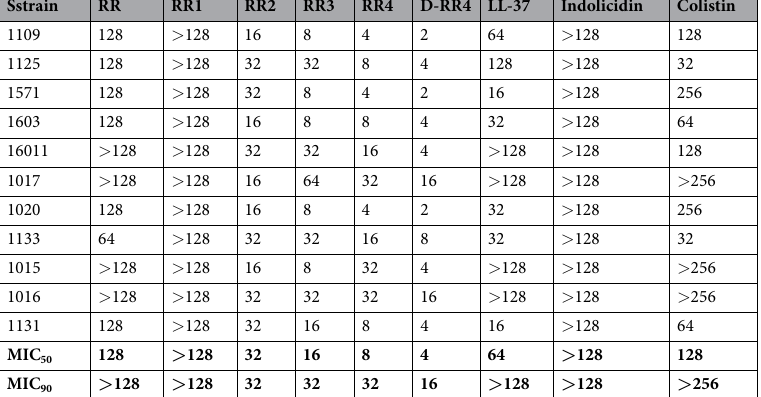
(Supplementary Fig. S2).